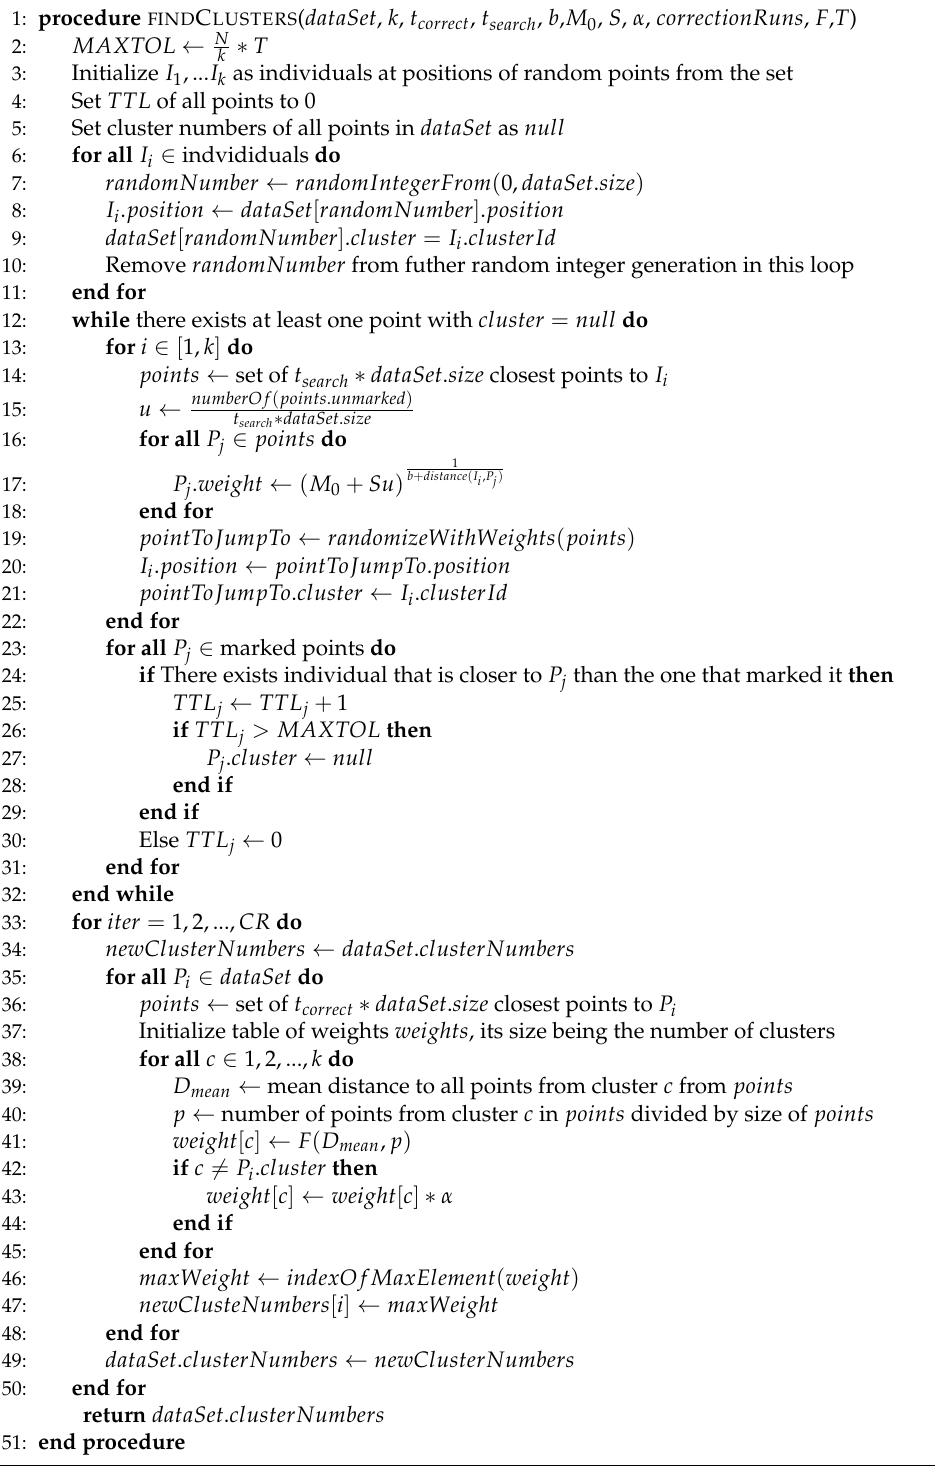
Algorithm 1 Clustering with Predatory Animals